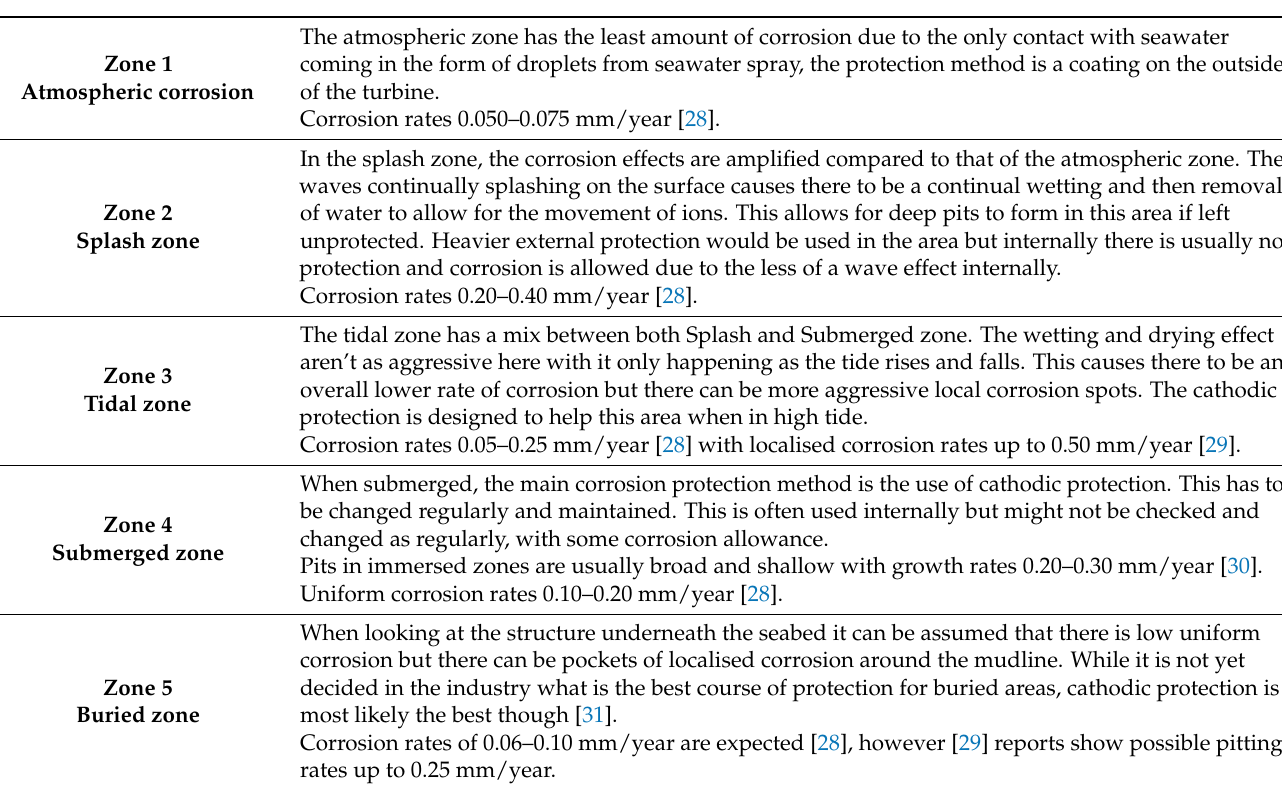
Figure 2. Suggested relative loss of metal thickness of unprotected steel on offshore wind turbine structure in seawater [27]. Table 1. Wind turbine corrosion zone explanation in relation to Figure 2.